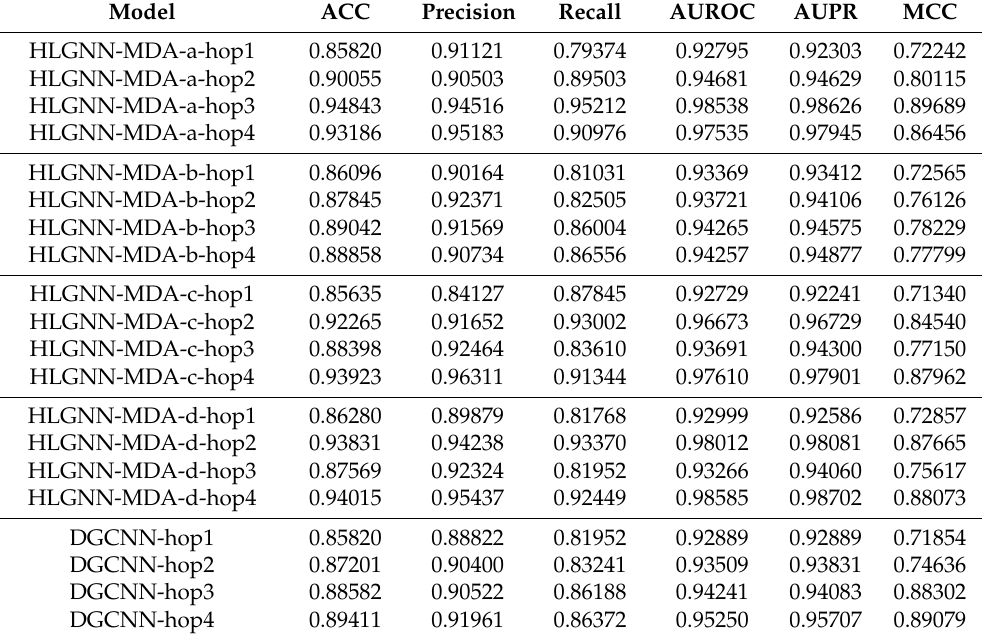
Table 3. Comparison between the four variations of HLGNN-MDA and DGCNN with different hops. Model ACC Precision Recall